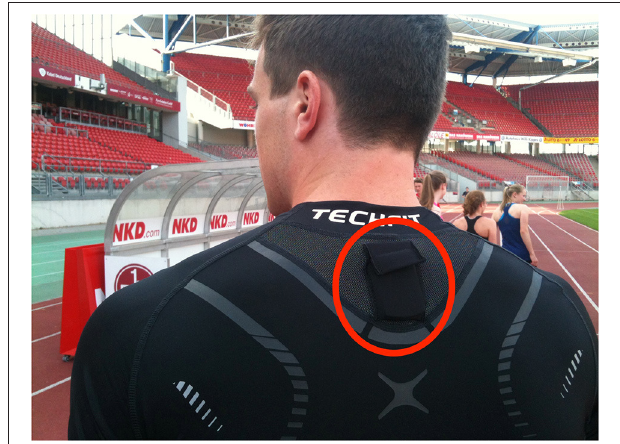
FIGURE 1 | Transmitter placement on the athletes. Transmitters were placed inside a specially designed